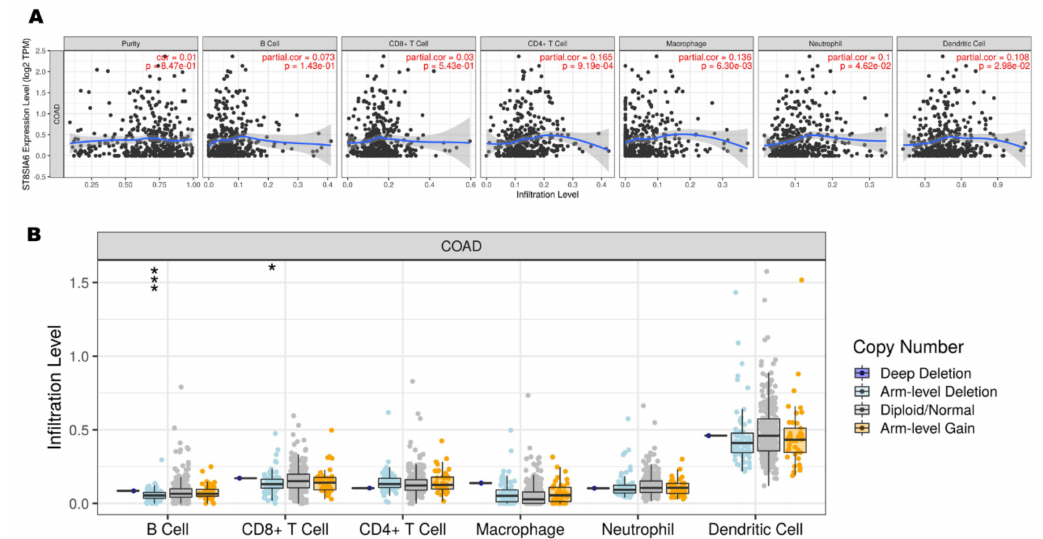
Figure 6. Correlations of ST8SIA6 expression with immune infiltration level in colon cancer. ( A ) ST8SIA6 expression is significantly related to tumor purity and has significant positive cor- relations with infiltrating levels of CD4+ T cells, macrophages, neutrophils, and dendritic cells in colon cancer. ( B ) ST8SIA6 CNA affects the infiltrating levels of B cells and CD8+ T cells in colon cancer. p -value Significant Codes: *** <0.001, * <0.05 compared with arm-level deletion, diploid/normal group, and arm-level gain.